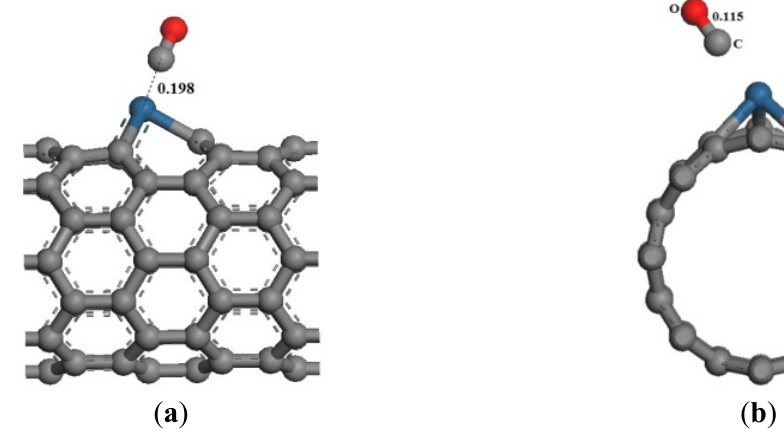
Figure 8. Structural model of CO-Pt-SWCNT adsorptive system. ( a ) Front view; ( b ) side view.